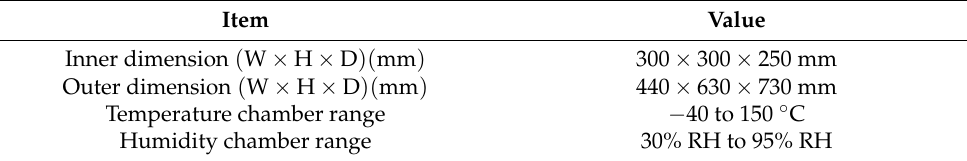
Table 6. Specification of the temperature and humidity chamber bench-top type SH-242.